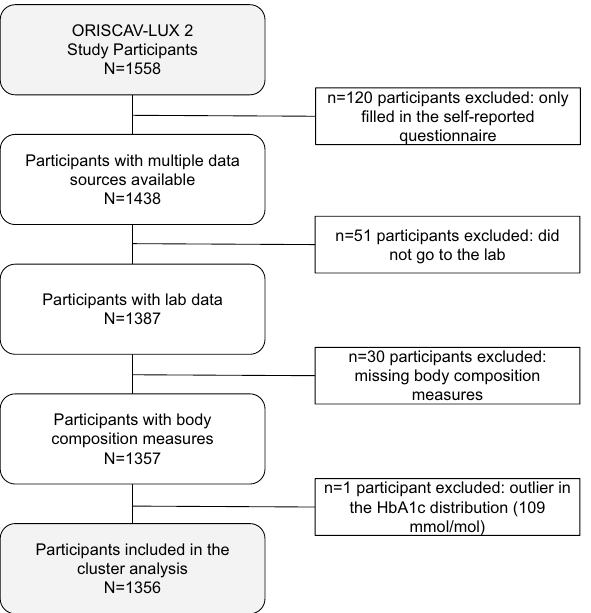
Figure 1. Flow-chart. Total participants included in the study (ORISCAV-LUX 2 study, N =